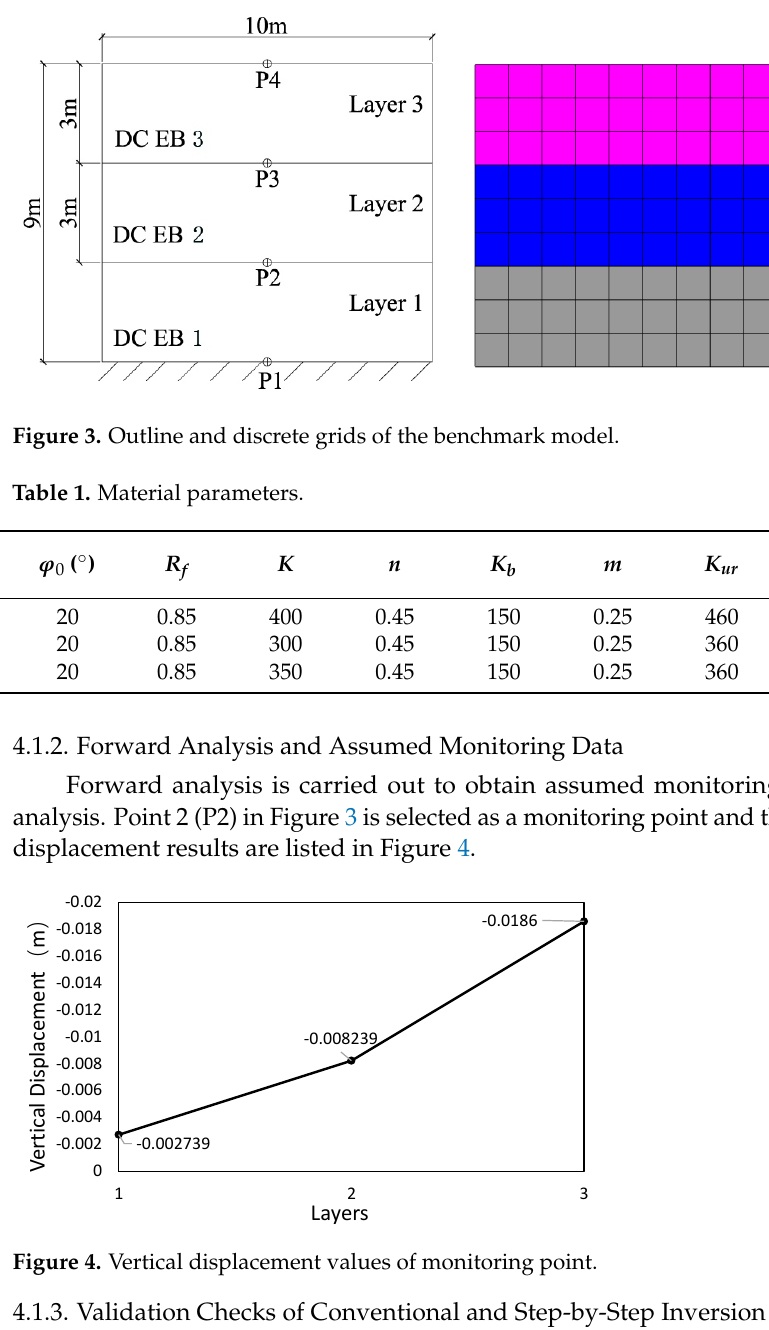
Figure 2. Flowchart of step-by-step inversion method.